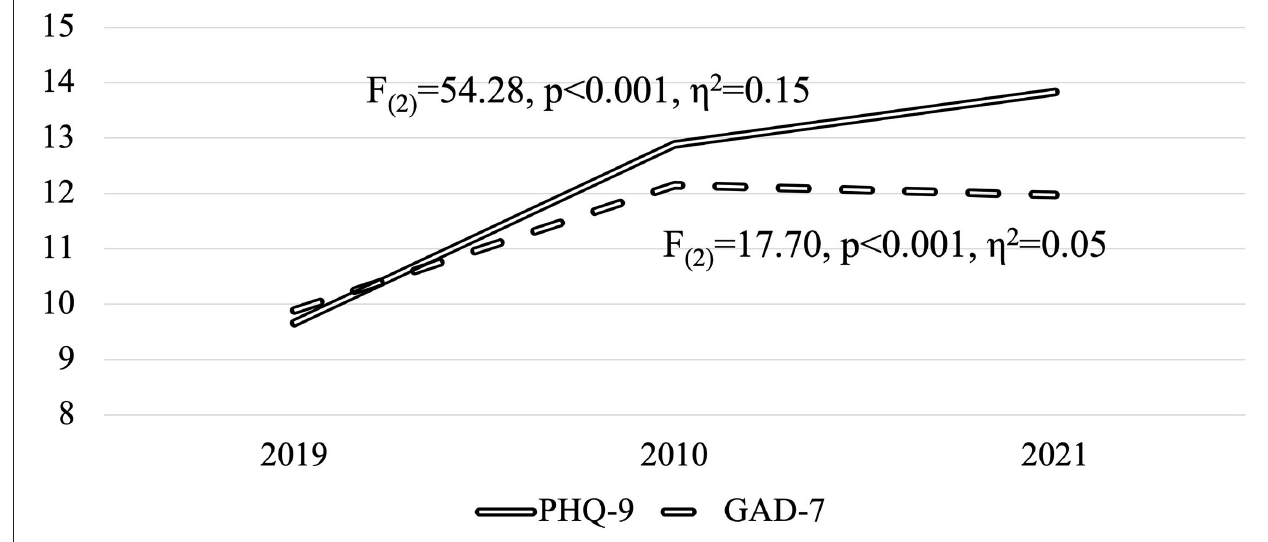
FIGURE 2 | Evolution of PHQ-9 and GAD-7 mean scores between 2019, 2020, and 2021.